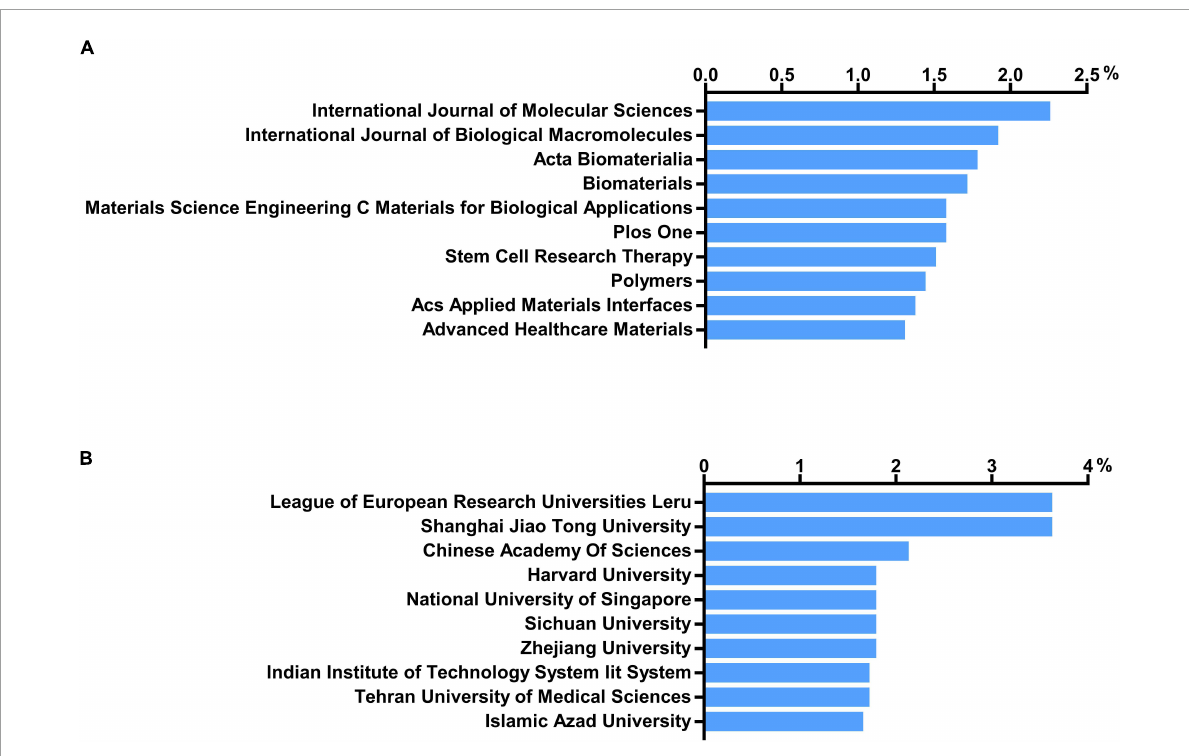
electrospinning (67 times), and hydrogels (60 times) appeared the most